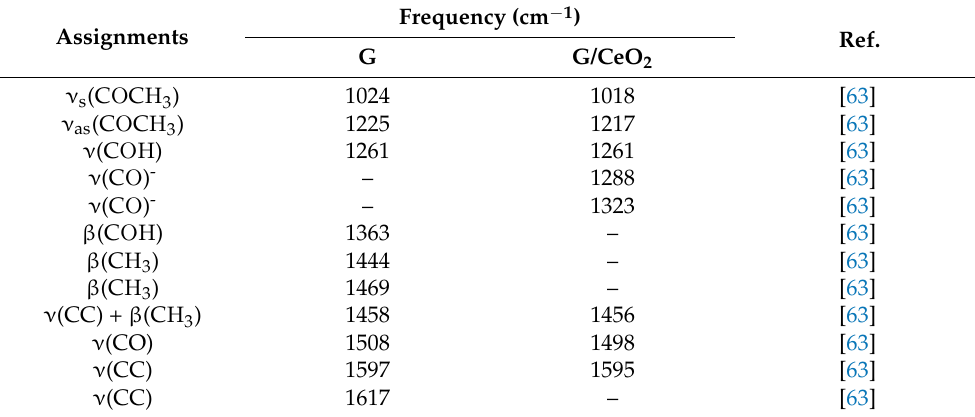
Table 2. Assignments of characteristic infrared bands of pure G and of G/CeO 2 (0.6